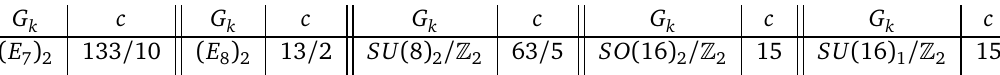
Dynkin labels. 7